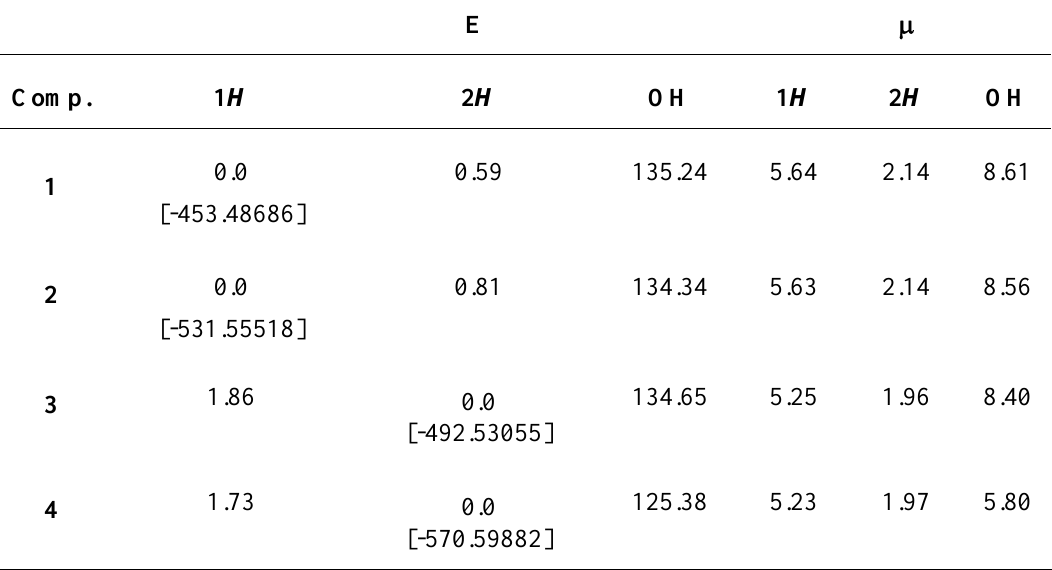
Table 2 . HF/6-31G* Differences in energy (kJ mol –1 ), energies in brackets (hartree) and dipole moments (Debye). E µ Comp.